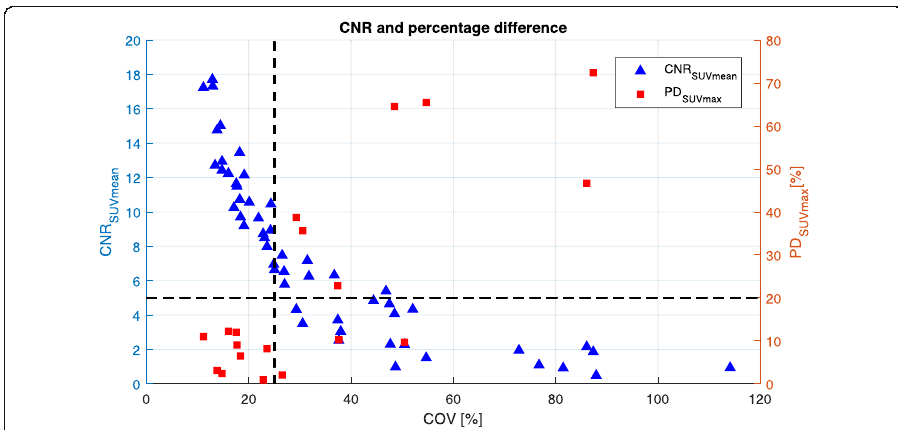
Fig. 2 The coefficient of variation plotted against the CNR SUVmean (left y -axes) and the percentage difference (right y -axis), determined for the 10-mm diameter sphere of the IQ phantom. For the CNR, the reconstructions of P1 and P2 are included, together with three additional non-overlapping reconstructions for the acquisition times of 240, 140, 100, 30, and 10 s/bed. The PD SUVmax is plotted against the COV of P1 reconstructions. The COV max = 25% (vertical dotted line), CNR = 5, and PD = 20% (horizontal dotted line) are indicated